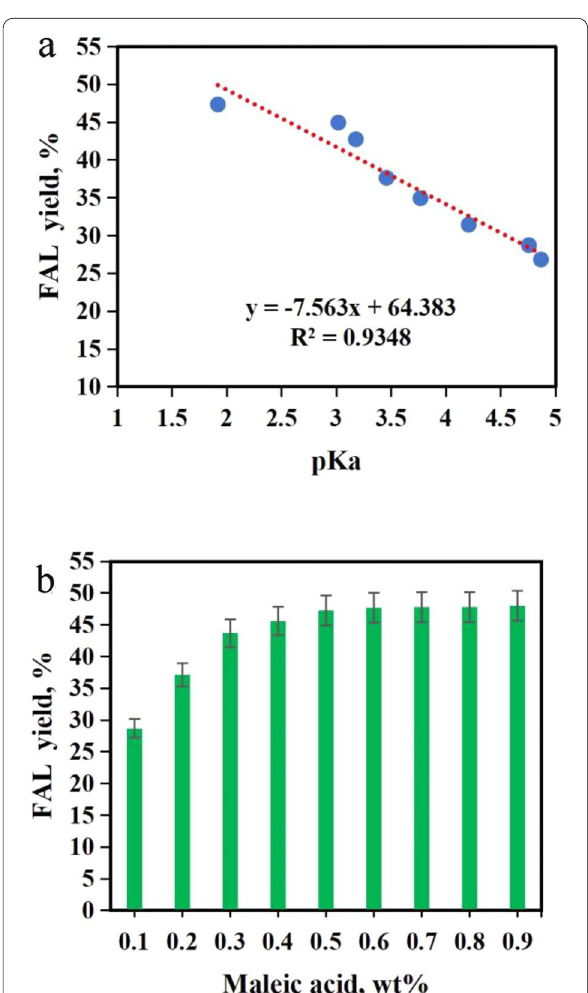
Fig. 2 Effect of organic acid with different pKa value on the yield of FAL in the acidic condition (Corncob 3.0 g, Sn‑GP 3.6 wt%, 170